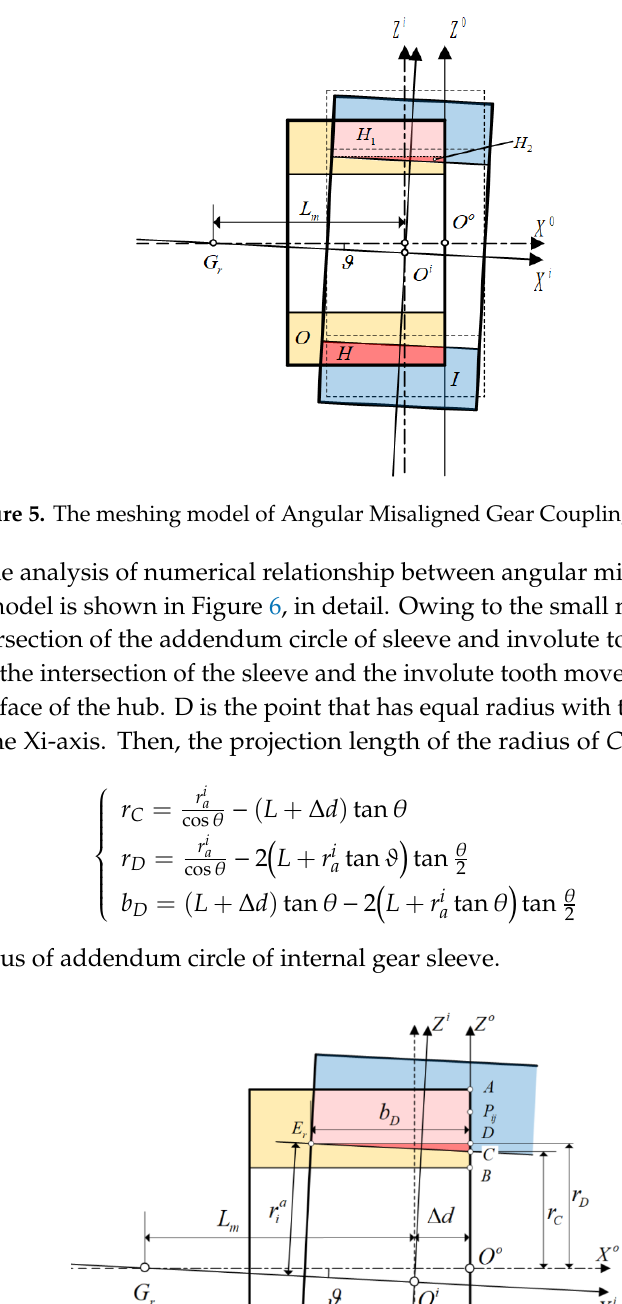
Figure 4. The meshing model of gear coupling without misalignment.